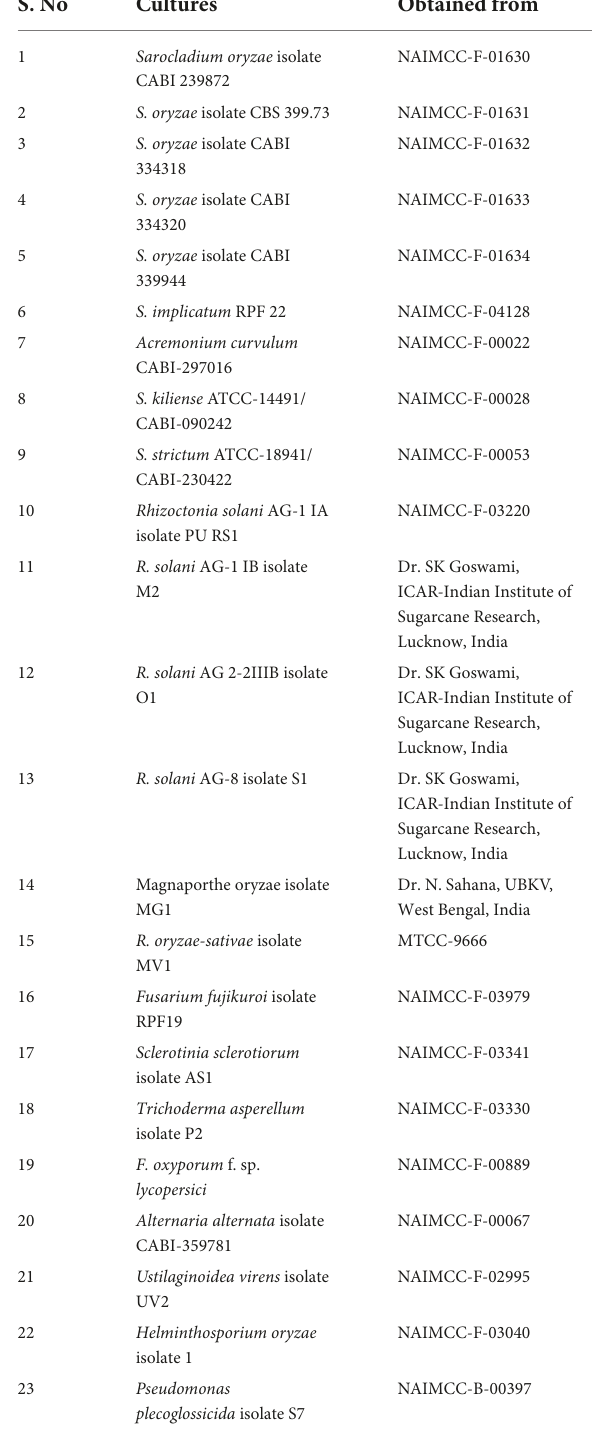
TABLE 1 Various bacterial and fungal cultures used for LAMP assay